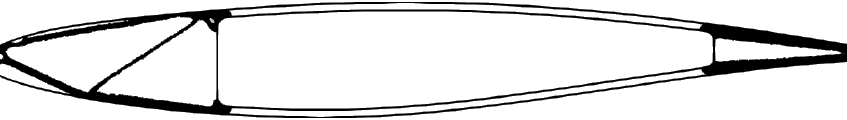
Figure 15. Topologically optimized structure for case 1.